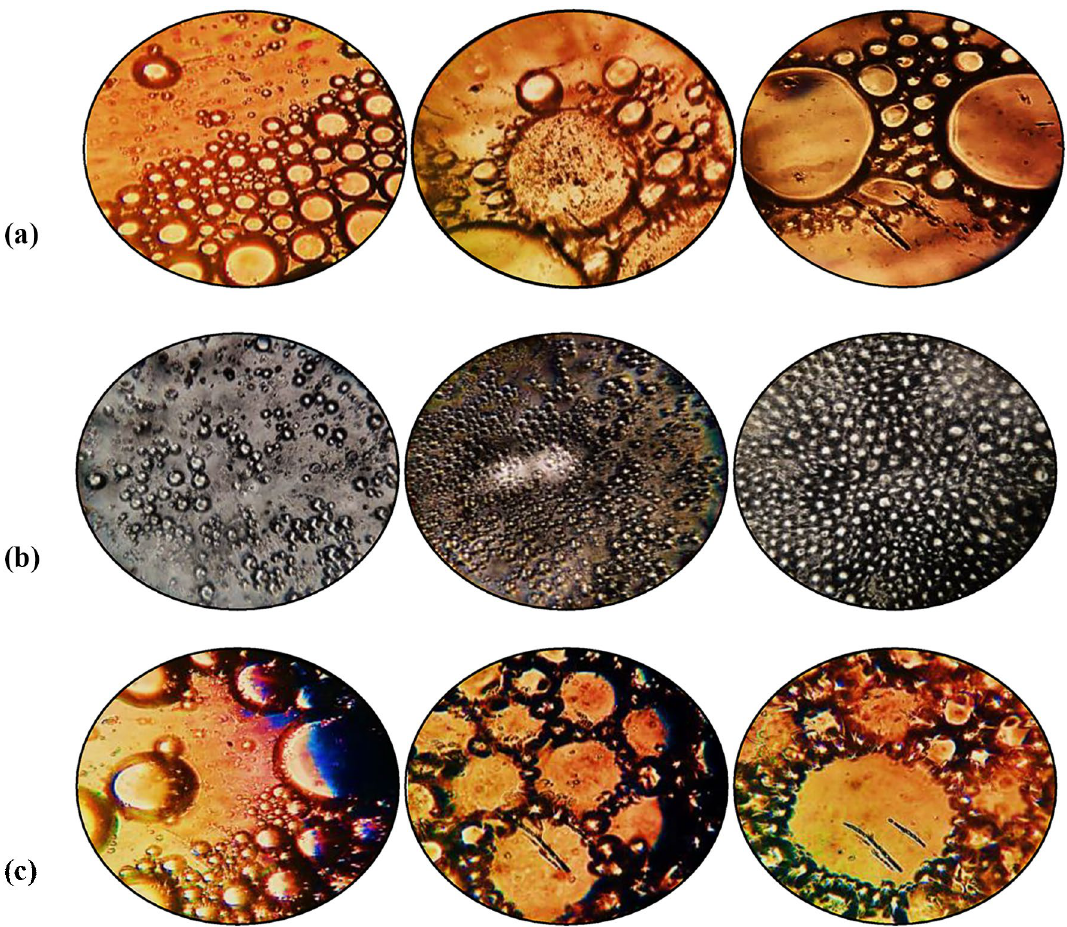
Figure 2. Emulsion structure of produced biosurfactants and bioemulsifier by light optical microscope (× 40) in different concentrations of 1.2 × CMC, CMC, and 2 × CMC (in order from left to right) for isolates ( a ) SH21, ( b ) SHA302, and ( c )